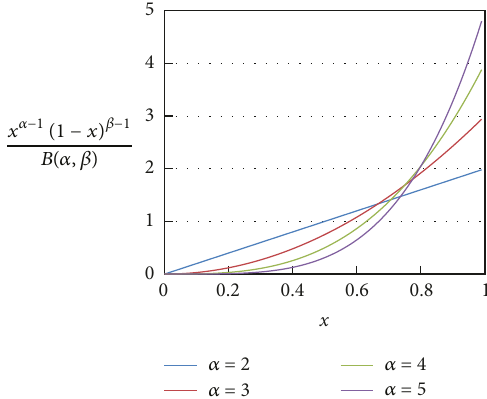
Figure 10: Beta distribution ( 𝛽 = 1